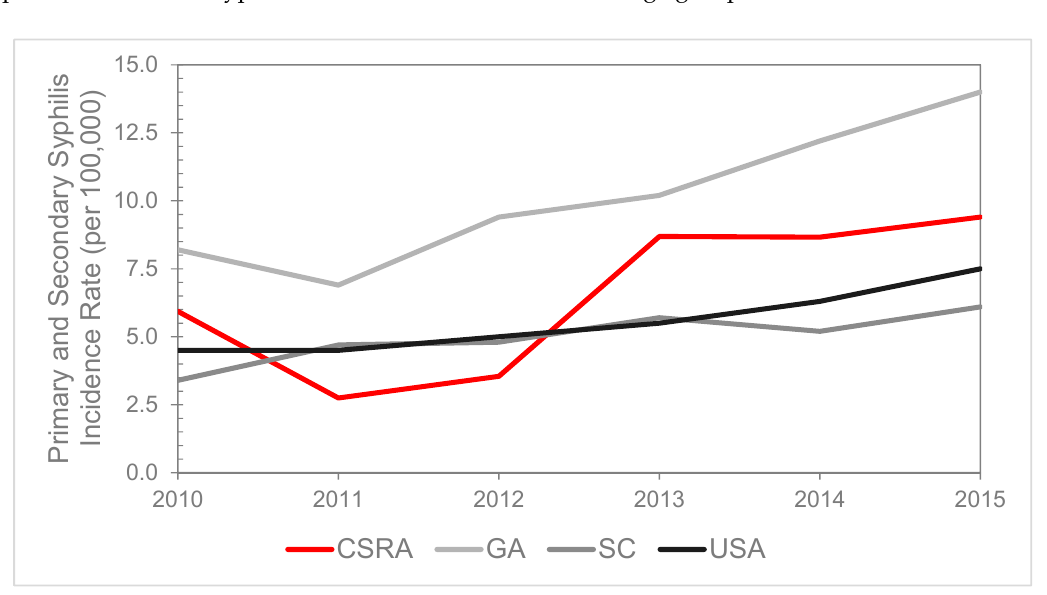
Figure 1. Incidence rate of primary and secondary syphilis in the Central Savannah River Area (CSRA) region compared to Georgia (GA), South Carolina (SC), and the national rates from 2010–2015. Table 1. Incidence rate (per 100,000 population) of primary and secondary syphilis cases in the CSRA, United States, 2010–2015.